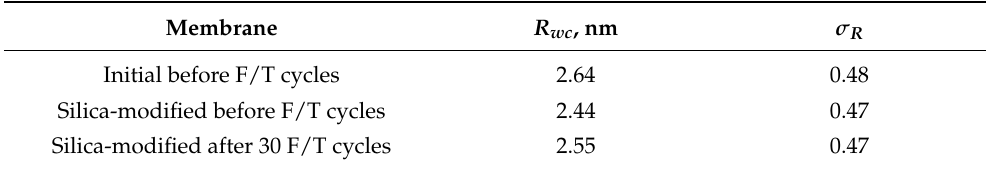
Figure 6. Experimental and model SAXS profiles of the initial water-swollen and silica-modified membranes. Table 5. Size of the ionic domains of the water-swollen Nafion ® 212 and silica-modified membrane before and after F/T cycles.